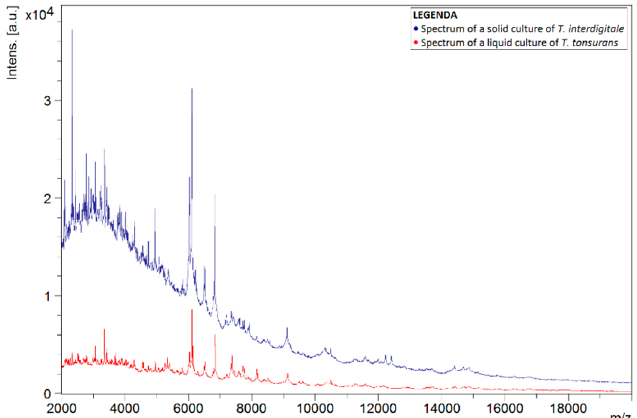
Figure 1. Spectra of liquid T. tonsurans isolate (red) and a solid T. tonsurans reference strain from the BCCM/IHEM collection (blue). Spectra show the signal intensity (Intens., in absorption units) of the ions detected by MALDI-TOF MS, as a function of their mass-to-charge ratio ( m / z , in kg/C).